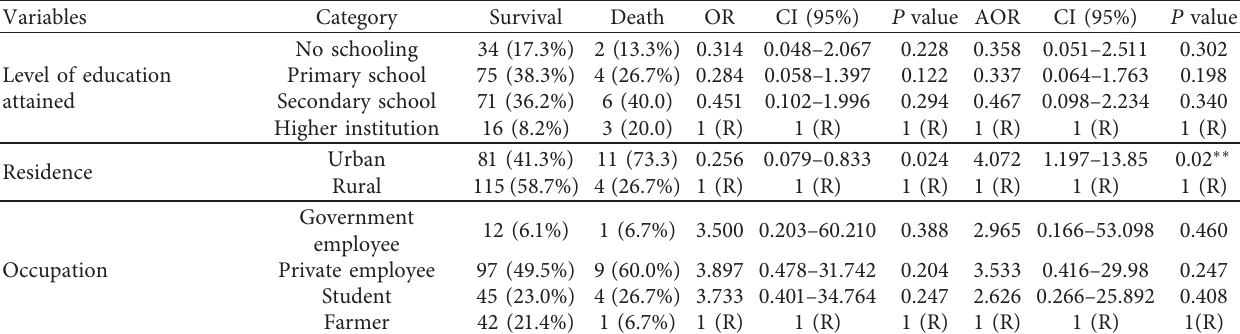
Table 6: Association of poisoning outcome with selected sociodemographic variables ( n � 211) in western Ethiopia, 2018. Variables